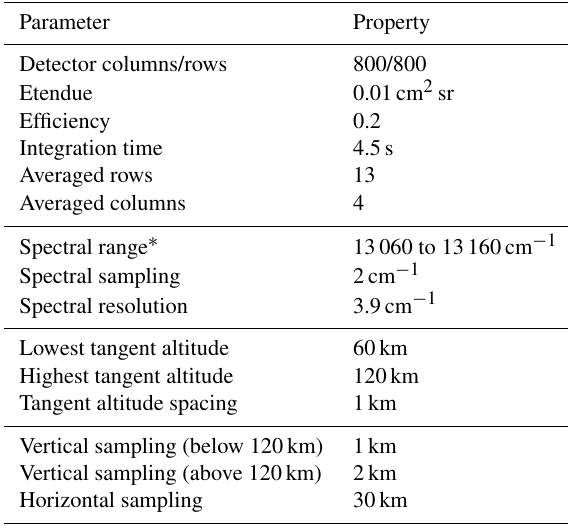
Table 2. Summary of detector and sampling